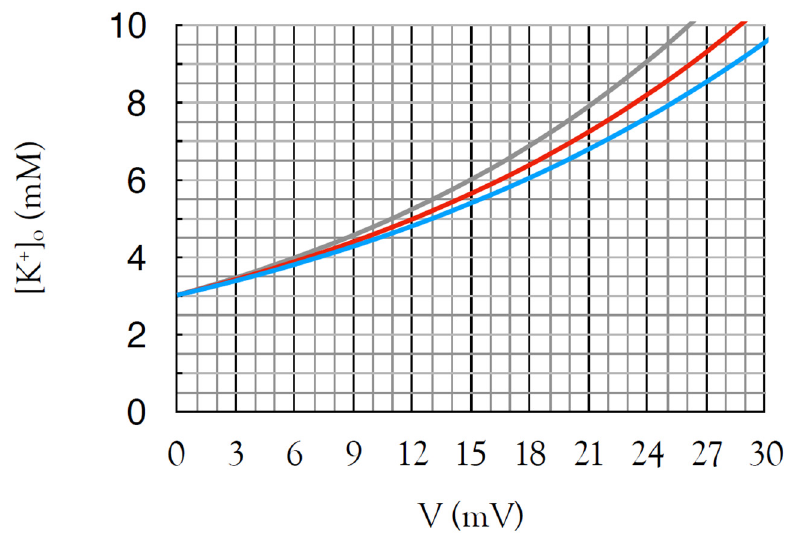
Figure 5. Calibration curve for ISM according to rearrangement of the Nernst equation with a bath- ing aCSF of 3 mM K + . Curves are for electrodes calibrated in 3 mM and 30 mM K + with responses of 60 mV (blue), 55 mV (red) and 50 mV (grey), which give voltage deflections of 18 mV, 16.5 mV and 15 mV, respectively, for increases in [K + ] o from 3 to 6 mM.